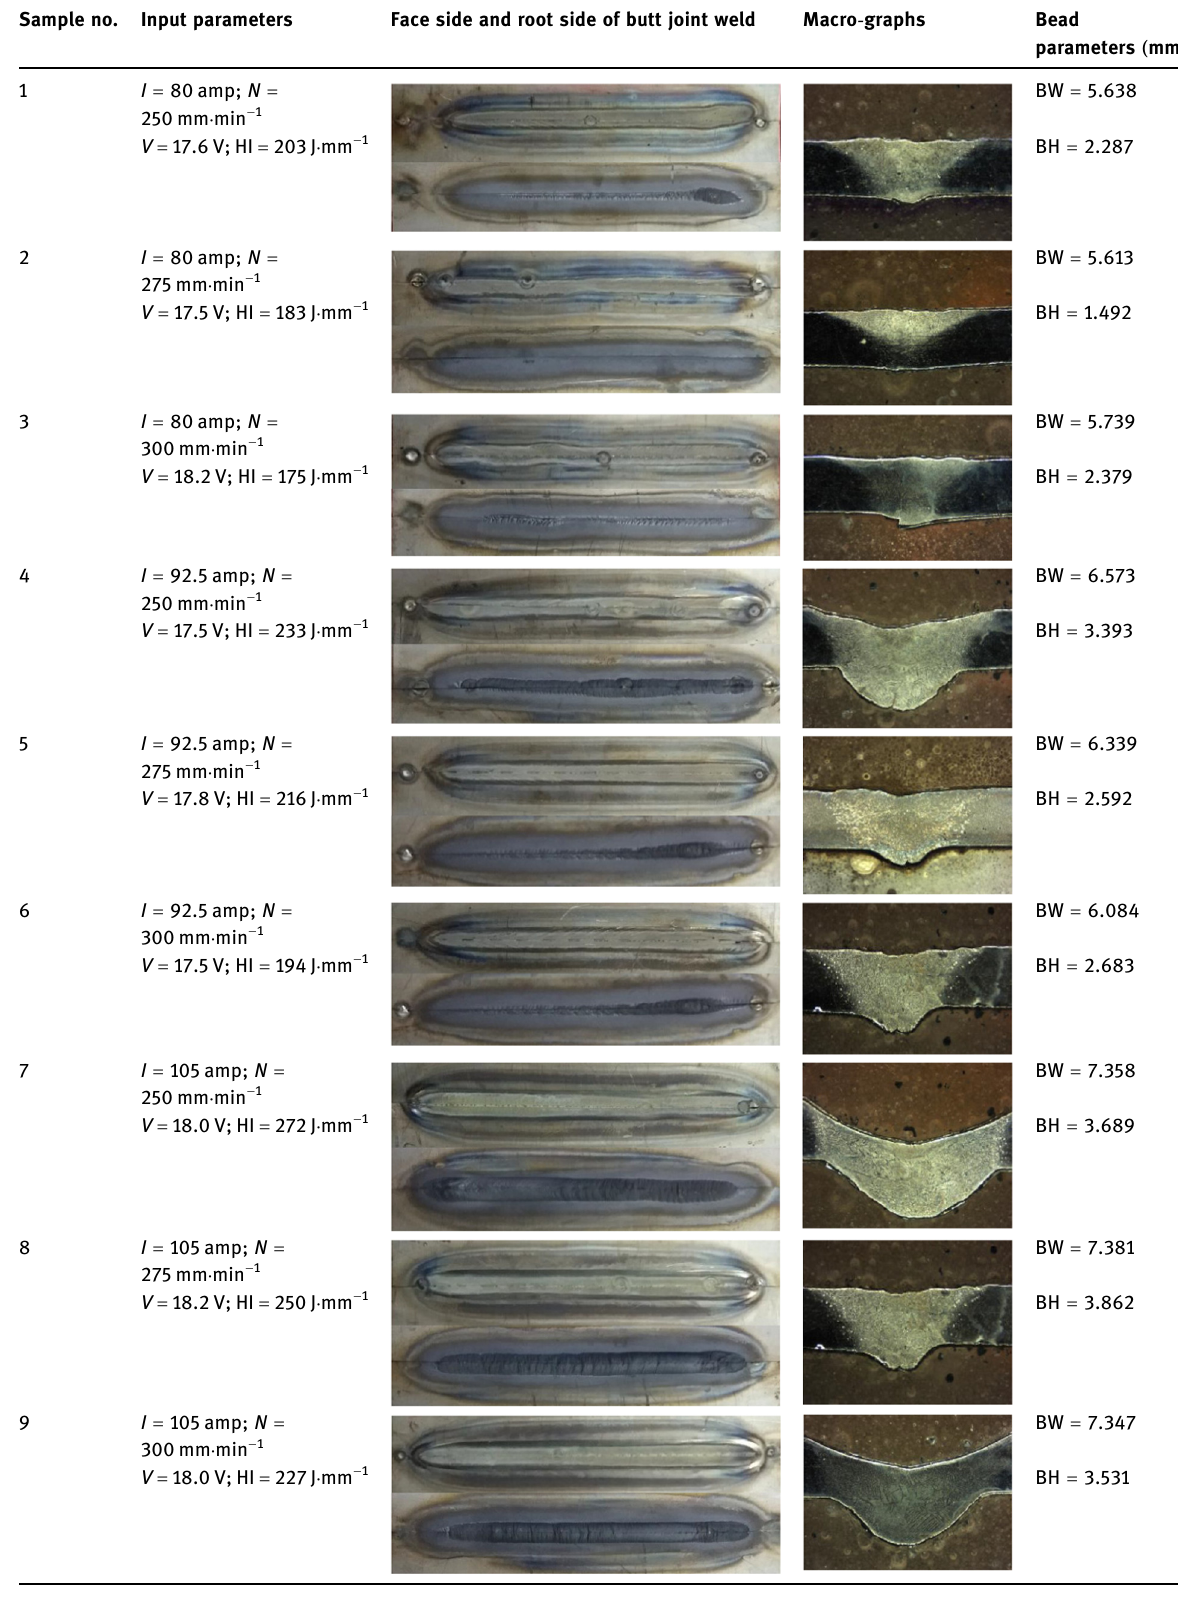
Table 3: Weld bead surface and the corresponding macro - graphs of butt welds Sample no. Input